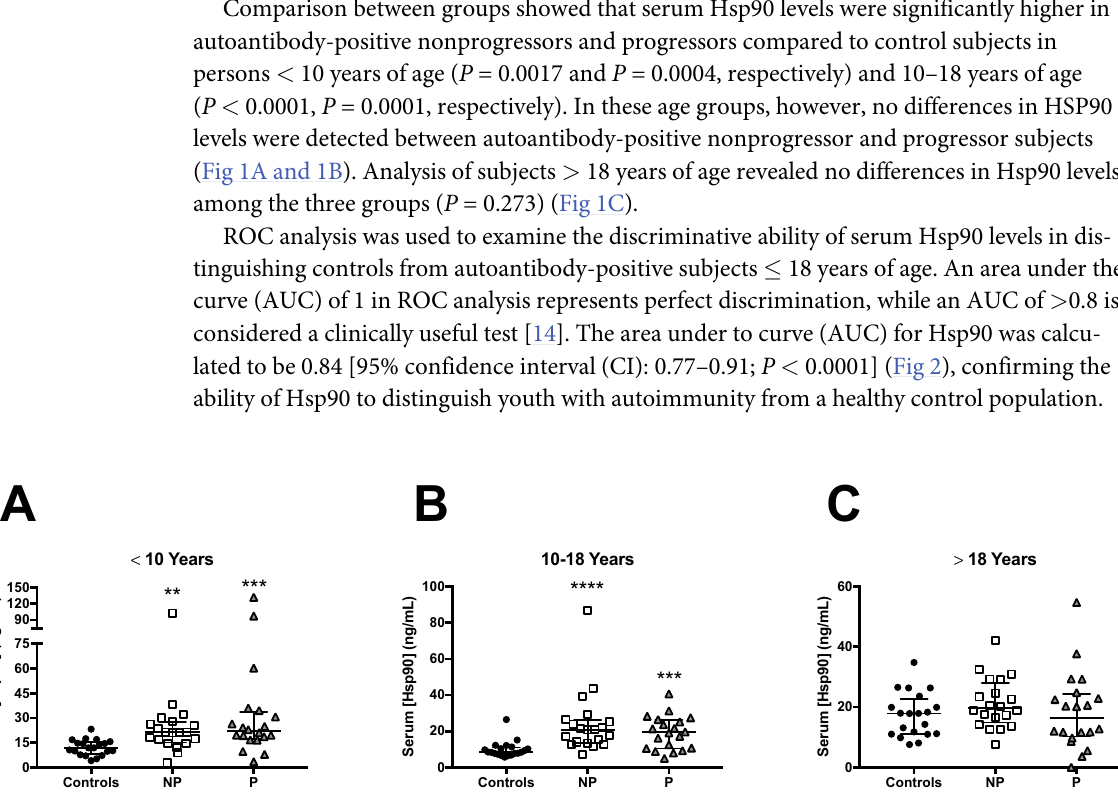
Fig 1. Serum Hsp90 values in TrialNet PTP study participants. Scatterplots of serum Hsp90 values for subjects < 10 years of age; n = 20 in each group (A), 10–18 years of age; n = 20 in each group (B), and > 18 years of age; n = 20 in each group (C). Kruskal-Wallis tests demonstrated significant differences between groups for subjects < 10 years of age ( P = 0.0001) and 10–18 years of age ( P < 0.0001), but not for subjects > 18 years of age. Dunn’s multiple comparisons tests revealed significant differences between autoantibody-positive nonprogressors and progressors compared to autoantibody-negative controls in subjects < 10 years of age ( P = 0.0017 and P = 0.0004, respectively) and 10–18 years of age ( P < 0.0001, P = 0.0001, respectively). No differences were observed between nonprogressor and progressor subjects for either age group. �� P < 0.01, ��� P < 0.001, ���� P < 0.0001. NP: nonprogressor, P: